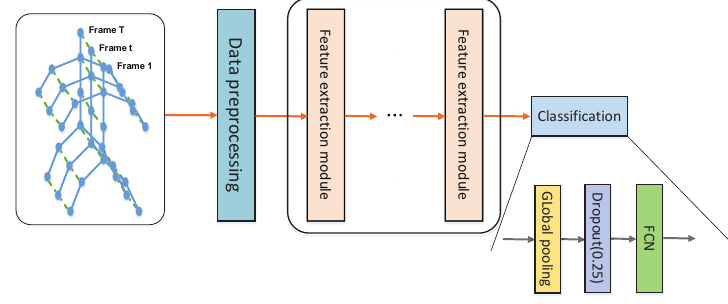
Figure 6. Overall network